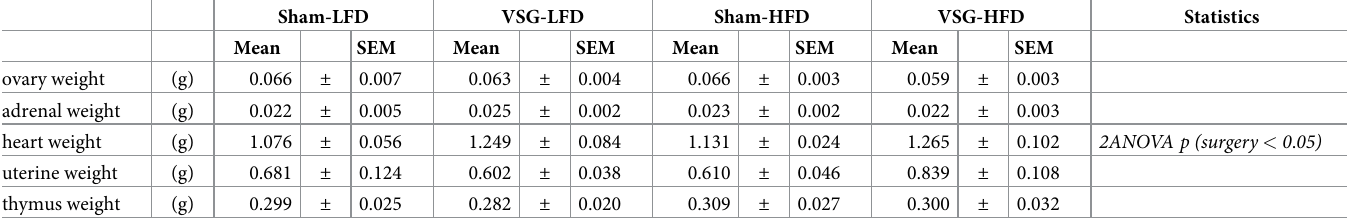
Table 1. Terminal body weight raw organ